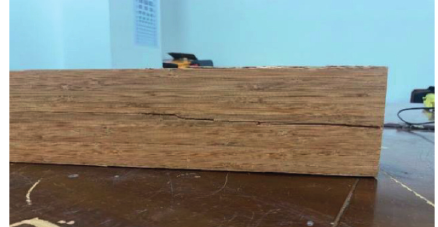
Figure 12: Failure mode of shear